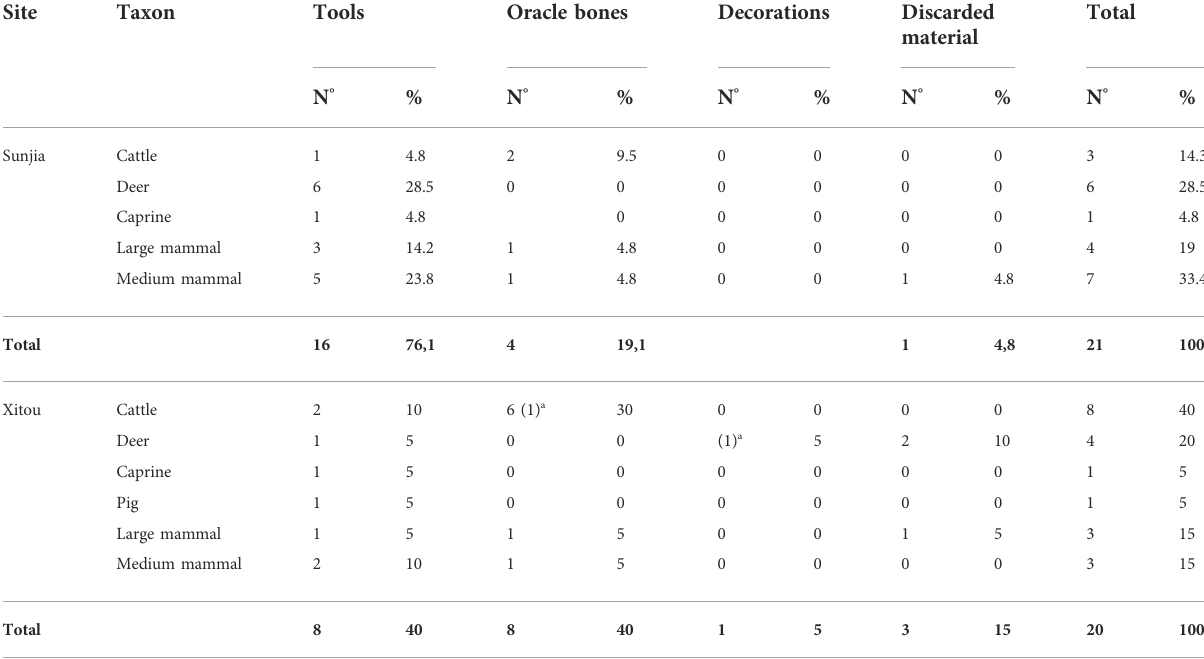
TABLE 3 Animal taxa by type of worked bones at Sunjia and Xitou. Site Taxon Tools